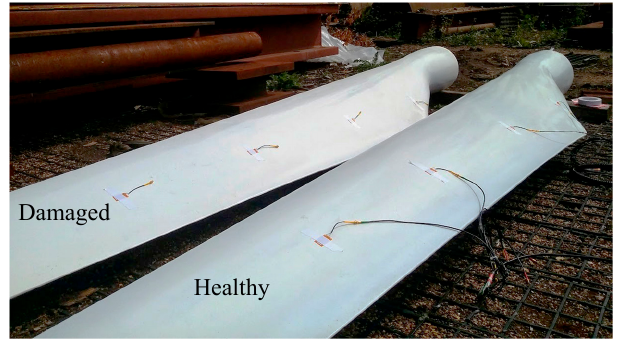
Figure 2. Wind turbine blades (WTBs) with delamination and without delamination in which the guided ultrasound wave tests were